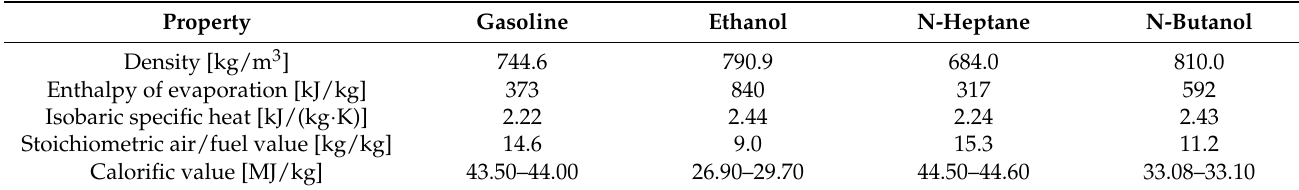
Table 1. Selected physical properties of fuels used in the research.